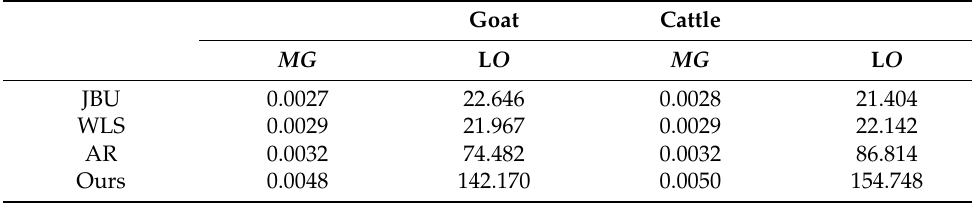
Table 1. Comparison of MG and L O values of reconstruction results. Goat Cattle MG L O MG L